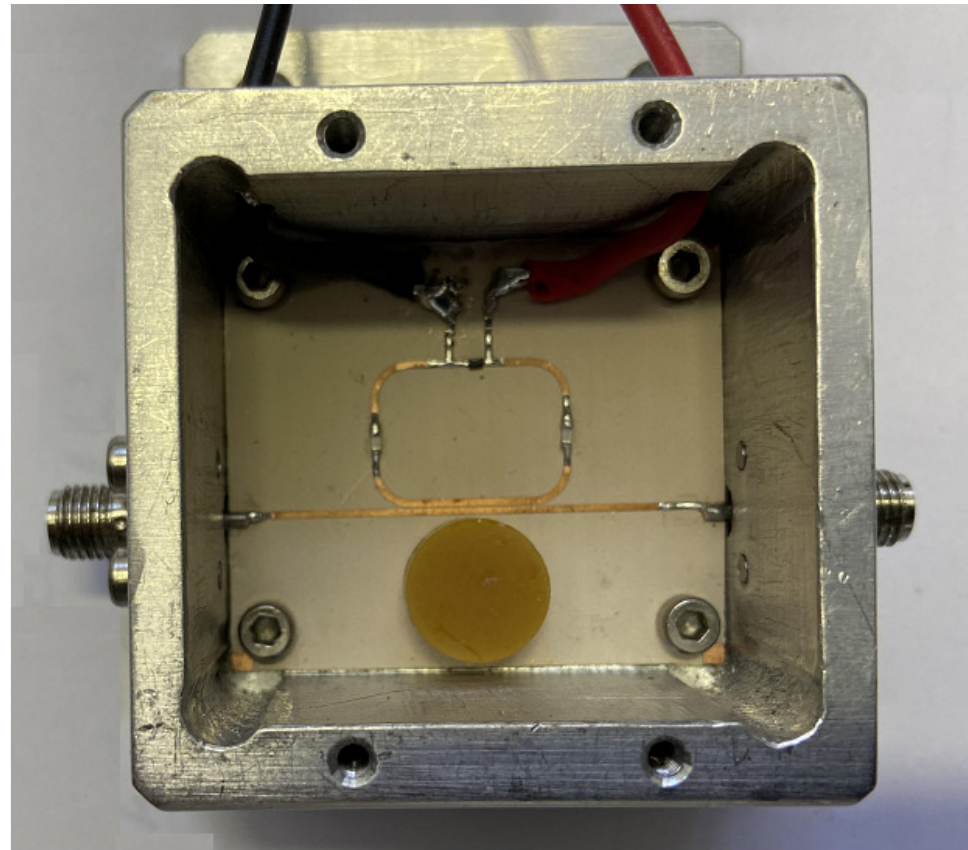
Figure 4. Prototype of the tuneable DR band-stop filter.